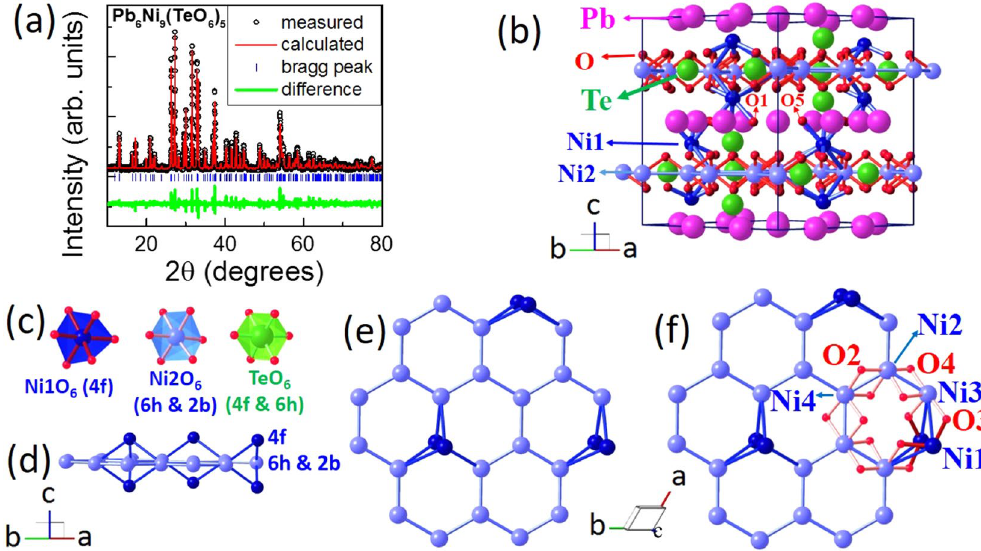
Figure 1. ( a ) Rietveld refinement on the XRD of the powder samples. ( b ) Crystal structure of Pb 6 Ni 9 (TeO 6 ) 5 . ( c ) The distorted NiO 6 ( 4f , 6h , and 2b ) and TeO 6 ( 4f and 6h ) octahedral environments in the structure. ( d ), ( e ) and ( f ) show the honeycomb-like layer in ab -plane filled with Ni 2 + ions. The layer is formed by four Ni 2 + ions (Ni1, Ni2, Ni3, and Ni4) and these ions are interacted with each other through O 2 −